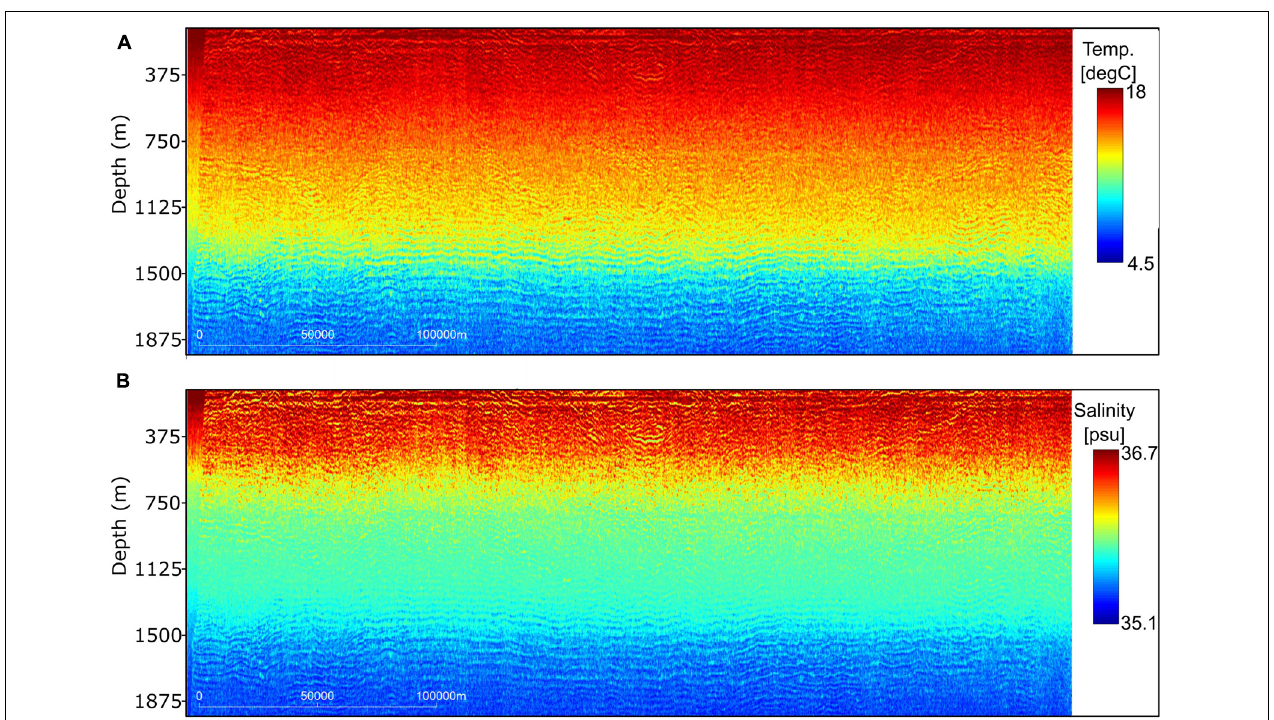
FIGURE 12 | Pointwise mean model of the set of inverted (A) temperature and (B) salinity models generated during the last iteration of the geostatistical inversion.